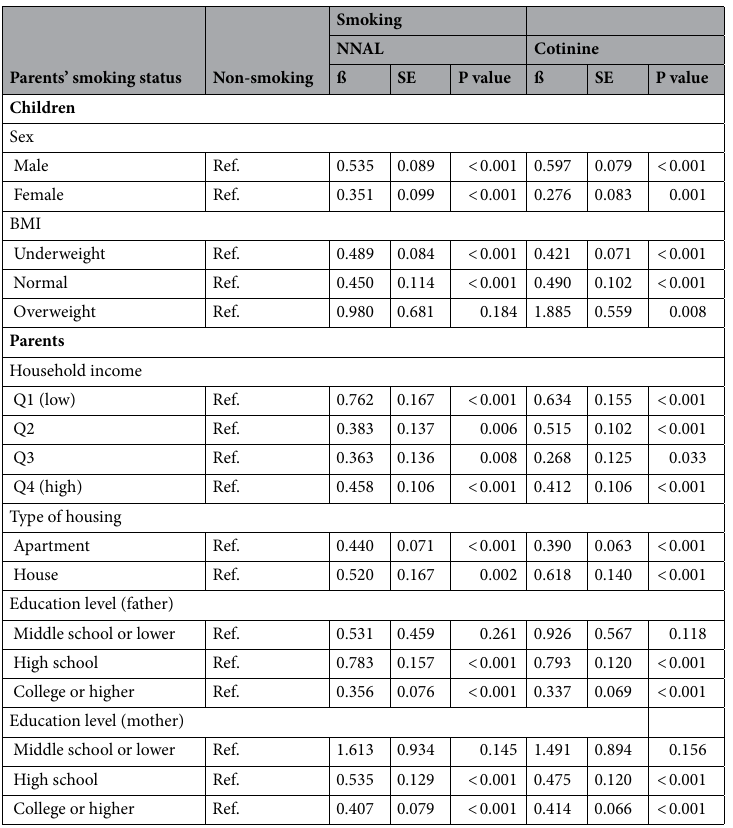
Table 3. Subgroup analysis of log-transformed NNAL and cotinine values according to parents’ smoking status. BMI body mass index, NNAL 4-(methylnitrosamino)-1-(3-pyridyl)-1-butanol, Ref. reference group of parents who are non-smokers, S.E. standard